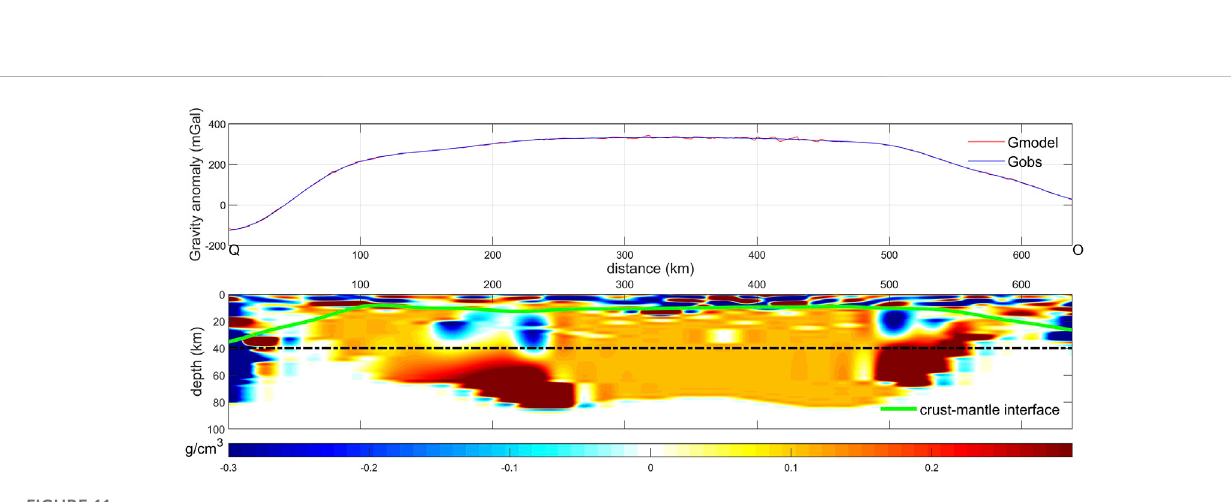
FIGURE 11 Inverted pro fi le density anomaly distribution of Q-O in the Mare Serenitatis.